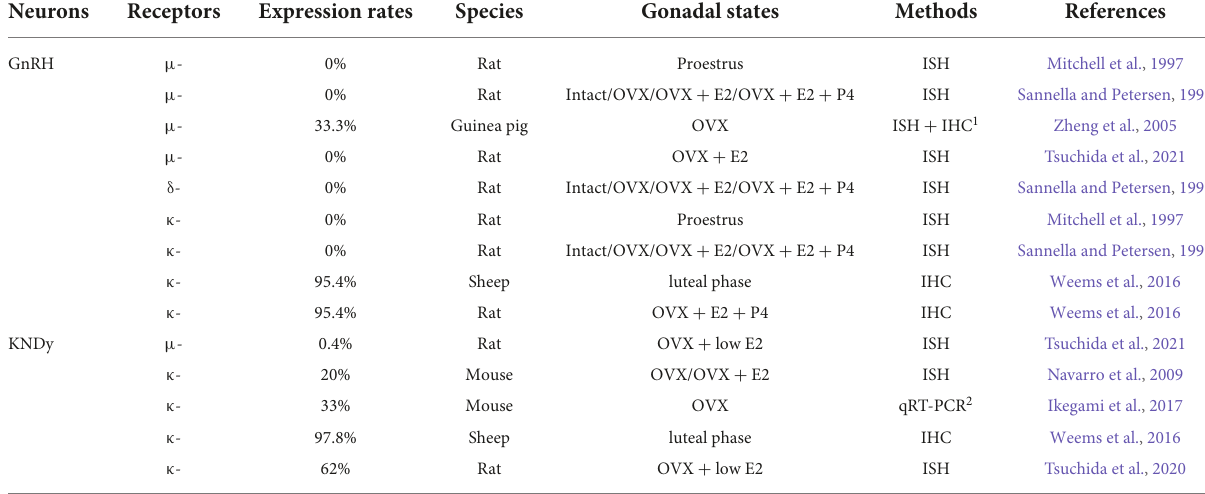
TABLE 6 Expression of opioid receptor mRNAs in gonadotropin-releasing hormone (GnRH) and KNDy neurons in female mammals.